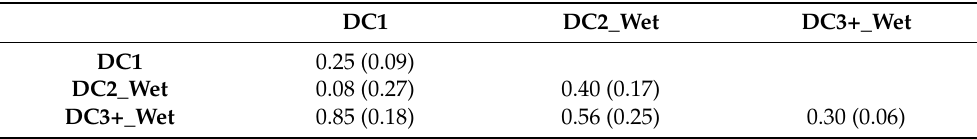
Table 15. Correlation matrix of days to calving traits to be utilised in a breeding program run as a tri-variate. Genetic correlations (below) and heritability estimates (diagonal) with standard error in